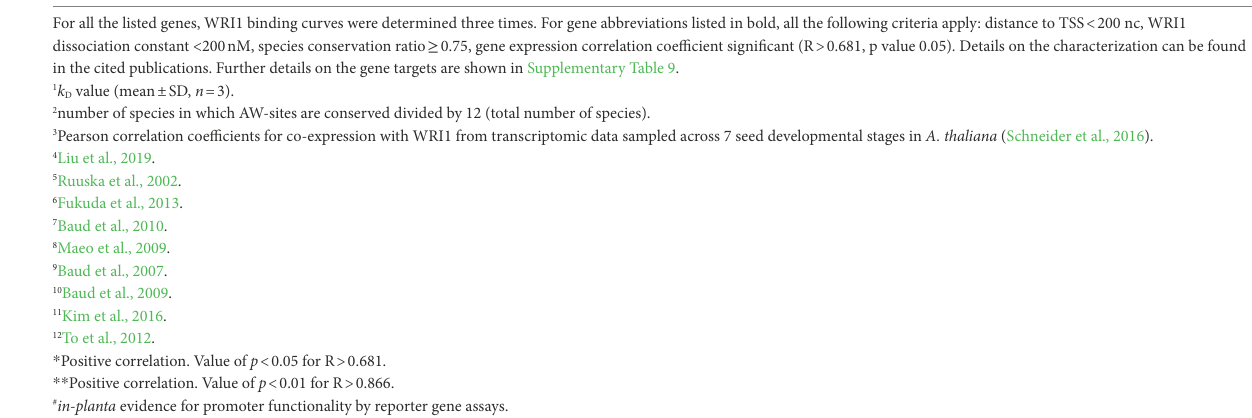
Gene abbreviation (description, gene